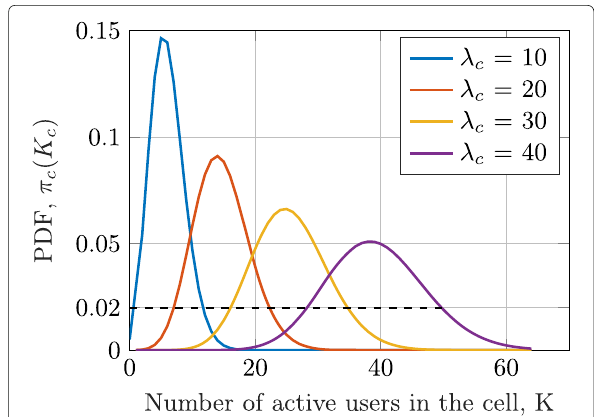
Fig. 4 Massive MIMO user distribution. PDF of the number of concurrently active users in massive MIMO cell with K max = 64 and different arrival